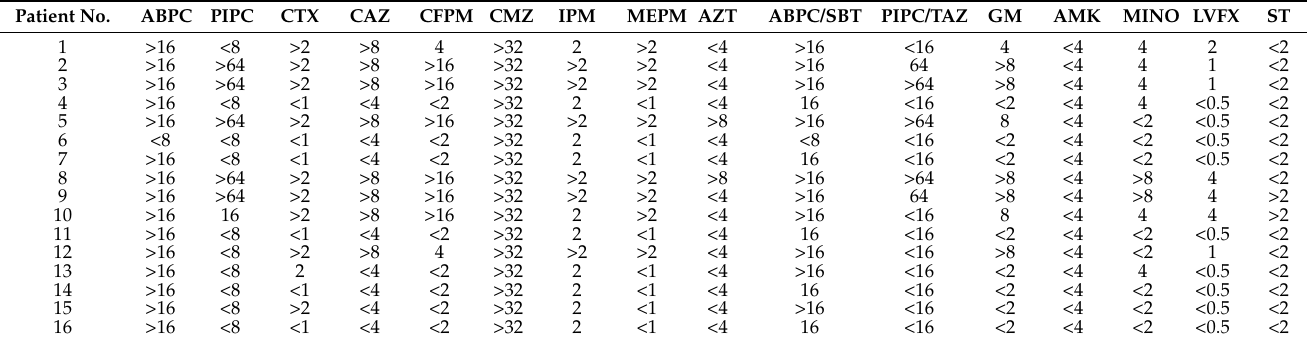
Table 1. Antibiotics susceptibolity profiles (minimum inhibitory concentrations, mg/L).